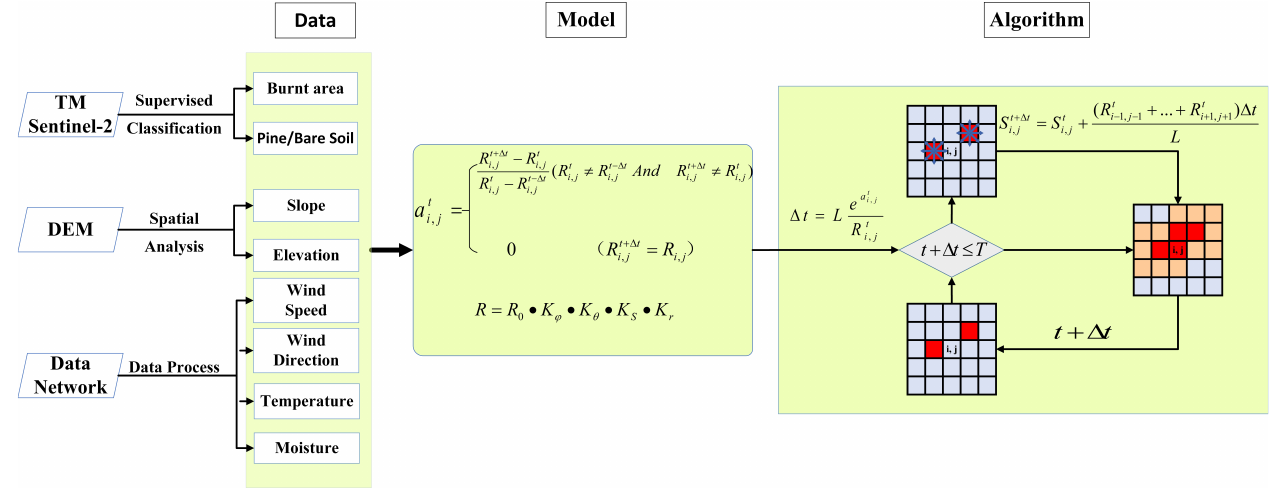
Figure 1. Design of an adaptive forest fire spread simulation algorithm based on cellular